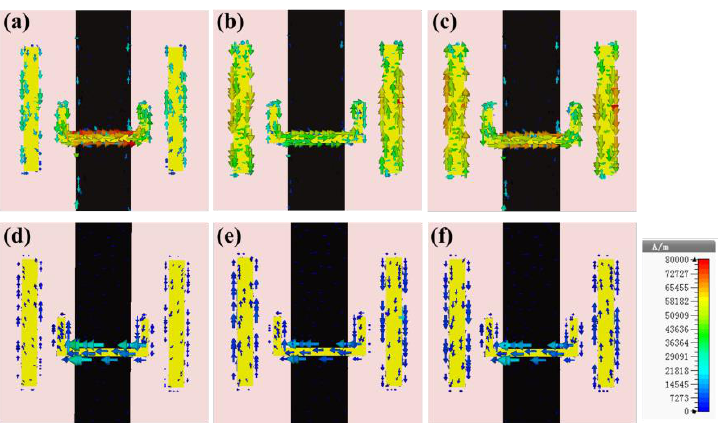
Figure 5. The calculated surface current distributions of the proposed metamaterial at transmission peak and dips with different Fermi energy. ( a – c ) f = 1.49, 1.71, 1.75 THz as E F = 0.05 eV; ( d – f ) f = 1.49, 1.71, 1.75 THz as E F = 0.20 eV.